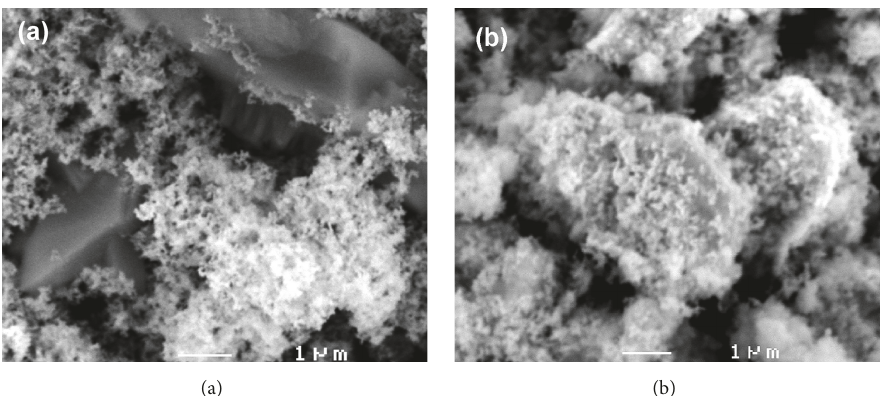
Figure 2: SEM micrograph of Sm-Fe-N/Co-B composite powders prepared by chemical reduction using an aqueous solution of (a) 0.1mol/l and (b) 0.025 mol/l cobalt sulfate heptahydrate.